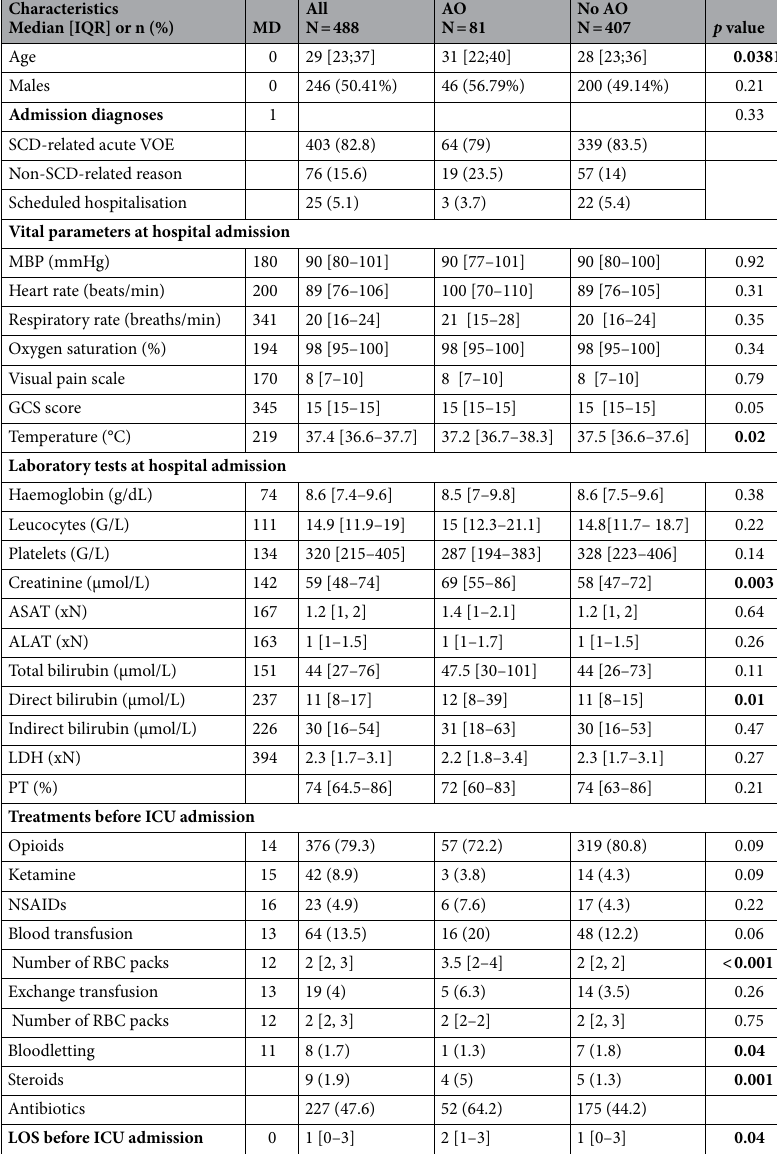
Table 2. Characteristics at hospital admission and process of care before ICU admission. Significant values are in [bold]. The p values were obtained by univariate logistic regression and reflect associations with